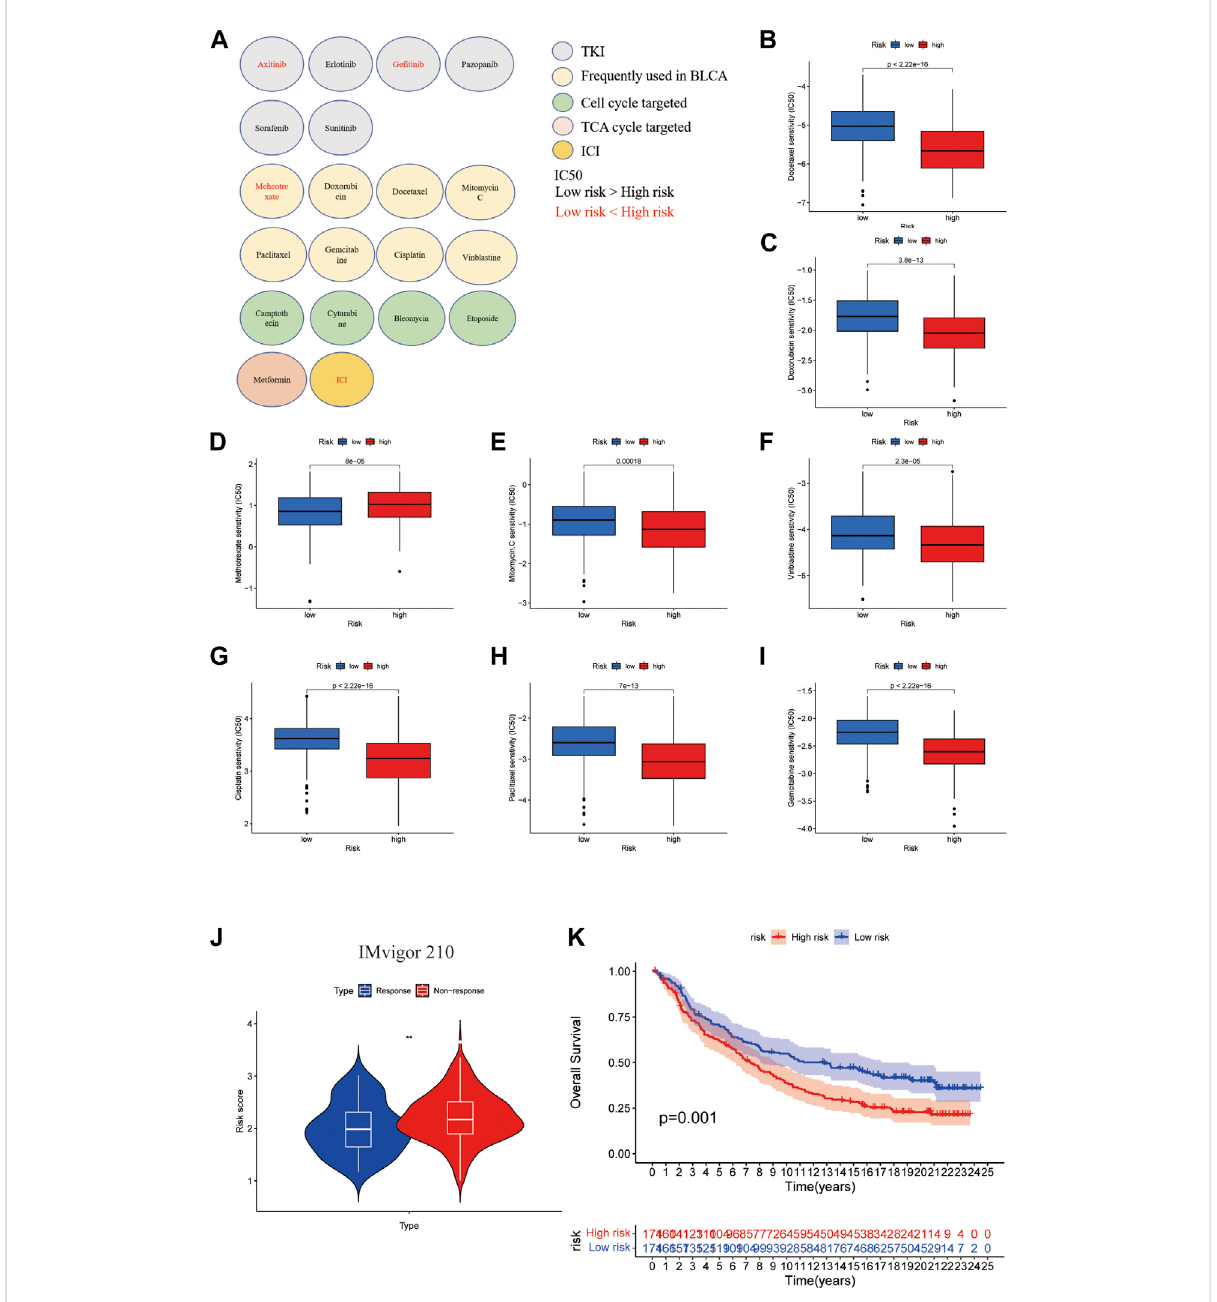
FIGURE 9 Drugsensitivityevaluationincuproptosis riskgroups. (A) Anoverview ofrolesofthecuproptosisscoringsystemonresponsetochemotherapy, targeted therapy, and immunotherapy. Drugs with lowerIC50 in thelow-risk group were shown inred.Drugs with lower IC50 inthehigh-risk group wereshown inblack. Exceptfor ICI, thedrug sensitivitieswereevaluated bythepRRophetic package. (B – I) Boxplots showed thedrug sensitivitiesof chemotherapydrugsthatarefrequentlyusedinBLCAtreatmentinhigh-andlow-riskgroups. (J) BoxplotshowedtheresponseofICIevaluated in high- and low cuproptosis risk patients in the IMvigor210 cohort. (K) Kaplan-Meier curves for high and low cuproptosis risk group patients in IMvigor210 cohort. ** p < 0.01. Abbreviations: IC50, half maximal inhibitory concentration; BLCA, bladder cancer; ICI, immune checkpoint